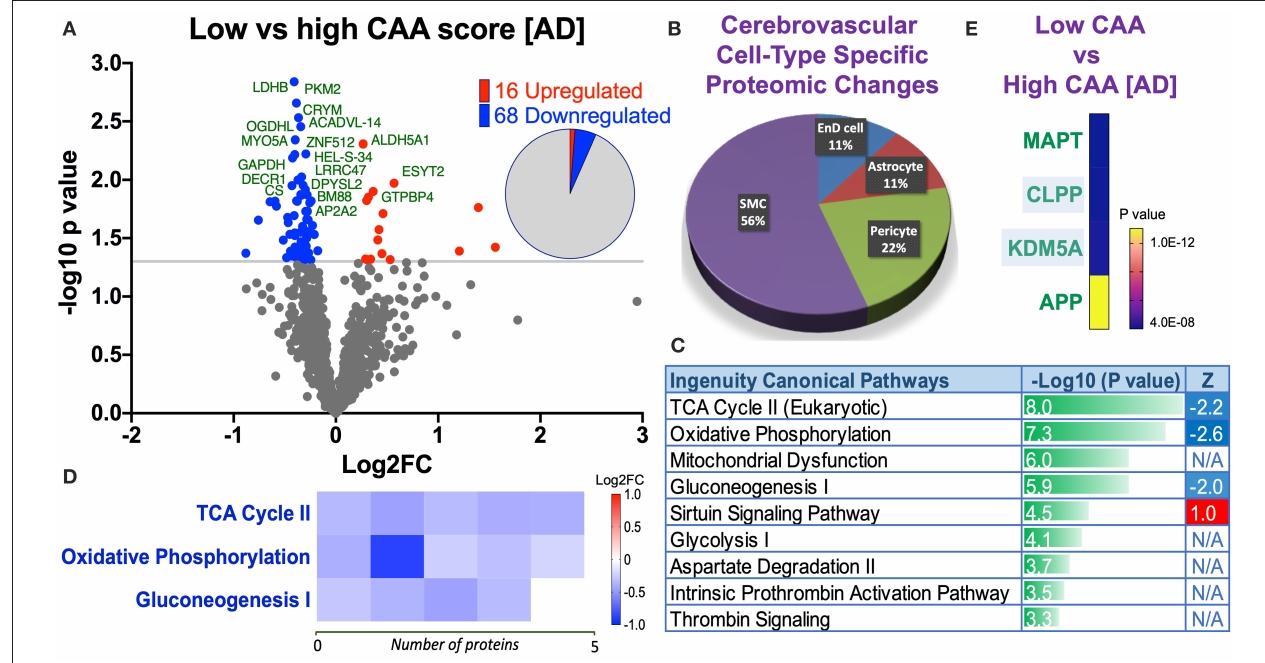
FIGURE 7 | Proteomic changes, cell origin, signaling pathways, upstream regulator factors observed from the cerebrovasculature isolated from the inferior frontal gyrus of low and high CAA [AD] cases. (A) Volcano plot of differentially expressed proteins in low vs. high CAA [AD] cases (pie chart inset shows up/down-regulated proteins, significant cut off set at 1.3 and red and blue points indicated up- or down-regulated significant proteins, respectively). (B) Pie Chart show origin of cell types where significant proteins from the comparisons between low and high CAA [AD] cases are observed. Data are generated from the number of significantly regulated proteins per specific cell type (from the PanglaoDB omic database), expressed as a percentage. (C) Canonical pathways identified from ingenuity pathway analyses (data depict –log10 [ P -value] and Z score generated from Fischer test of an overlap with the IPA knowledgebase; blue—downregulated and red—upregulated), and (D) shows heat map of the top 3 pathways and the corresponding number of significantly regulated proteins altered per pathway and their Log2 fold change expression level. (E) Shows Top 4 identified upstream regulators from the ingenuity pathway analyses of differentially regulated proteins in low and high CAA [AD] cases ( light blue highlighted text indicates that the upstream regulator is predicted to be activated